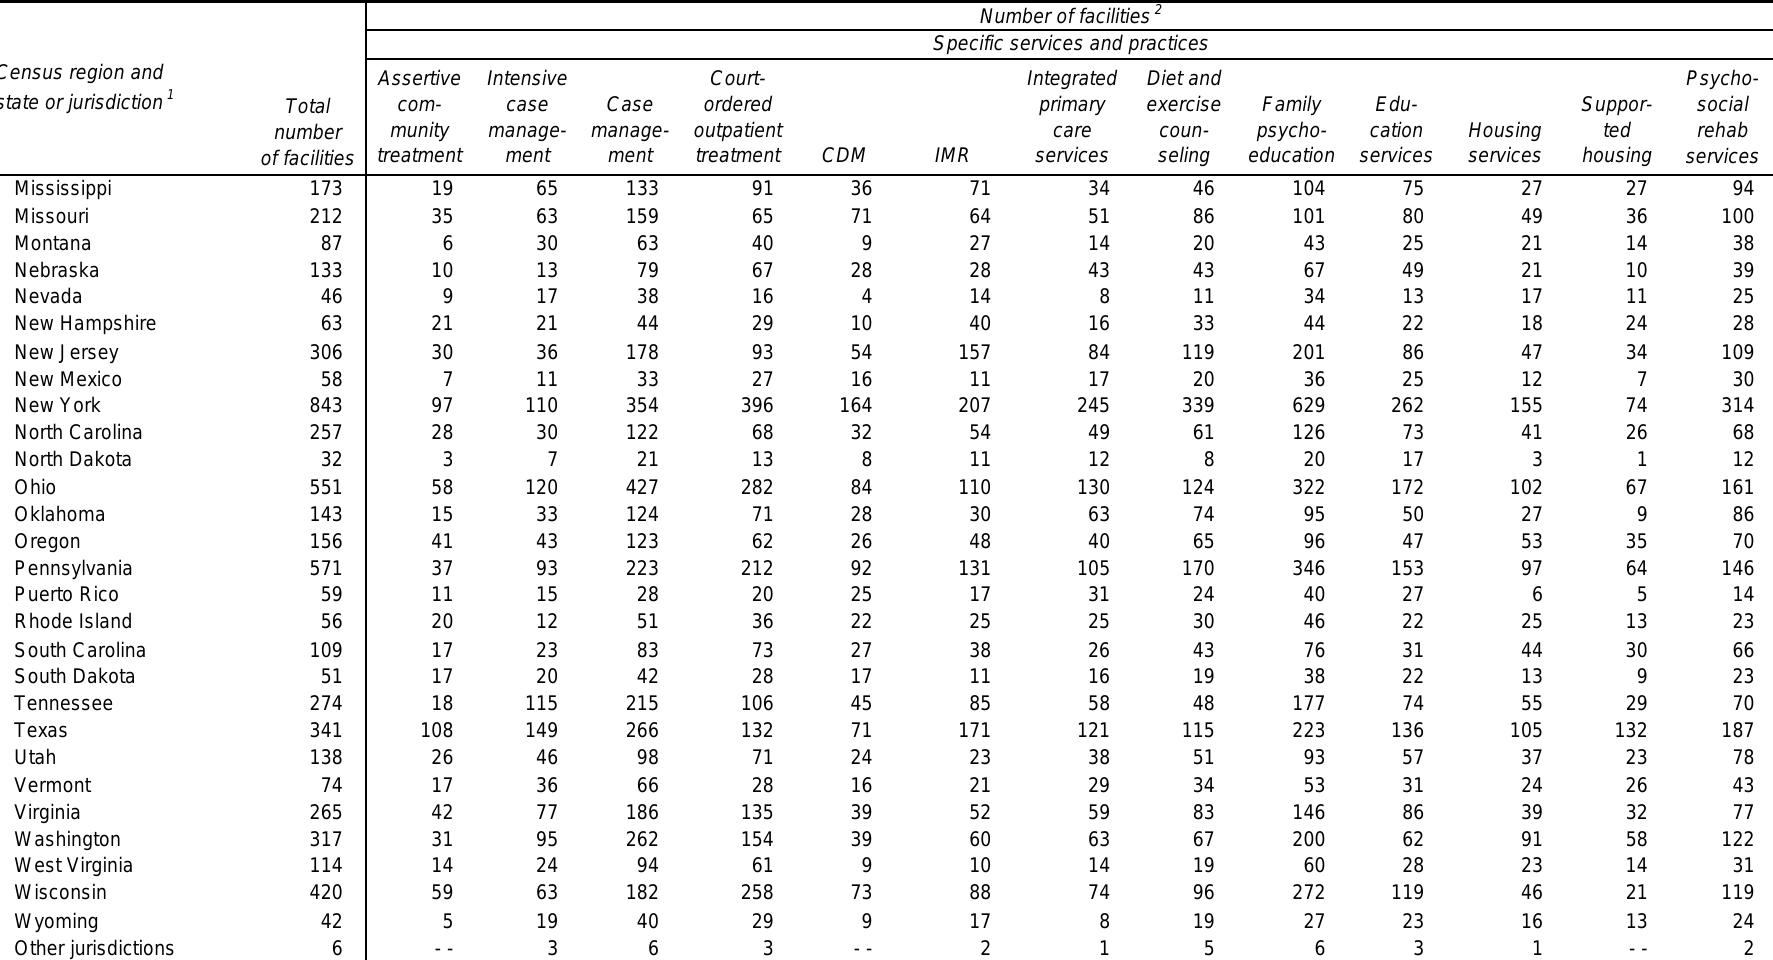
Continued. See notes at end of